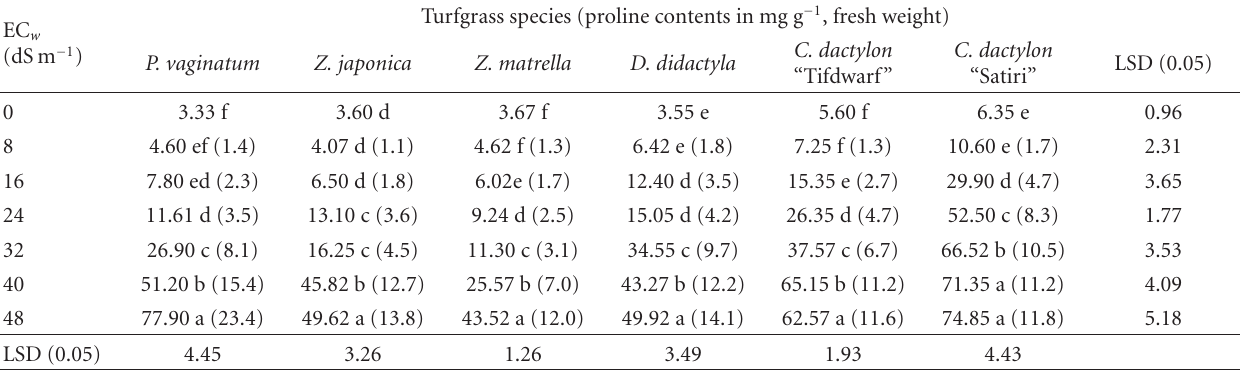
Table 4: E ff ect of salinity on leaf proline content of six turfgrass